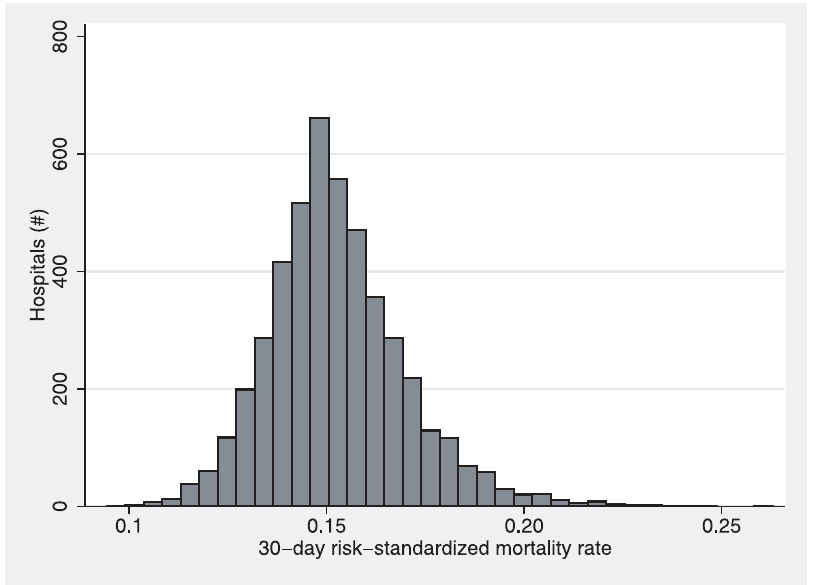
Figure 2. Distribution of hospital-level standardized 30-day pneumonia mortality rates. Risk-standardized mortality rates for the 4,684 hospitals are based on the administrative claims model using data for 449,296 Medicare patients discharged during calendar year 2000.